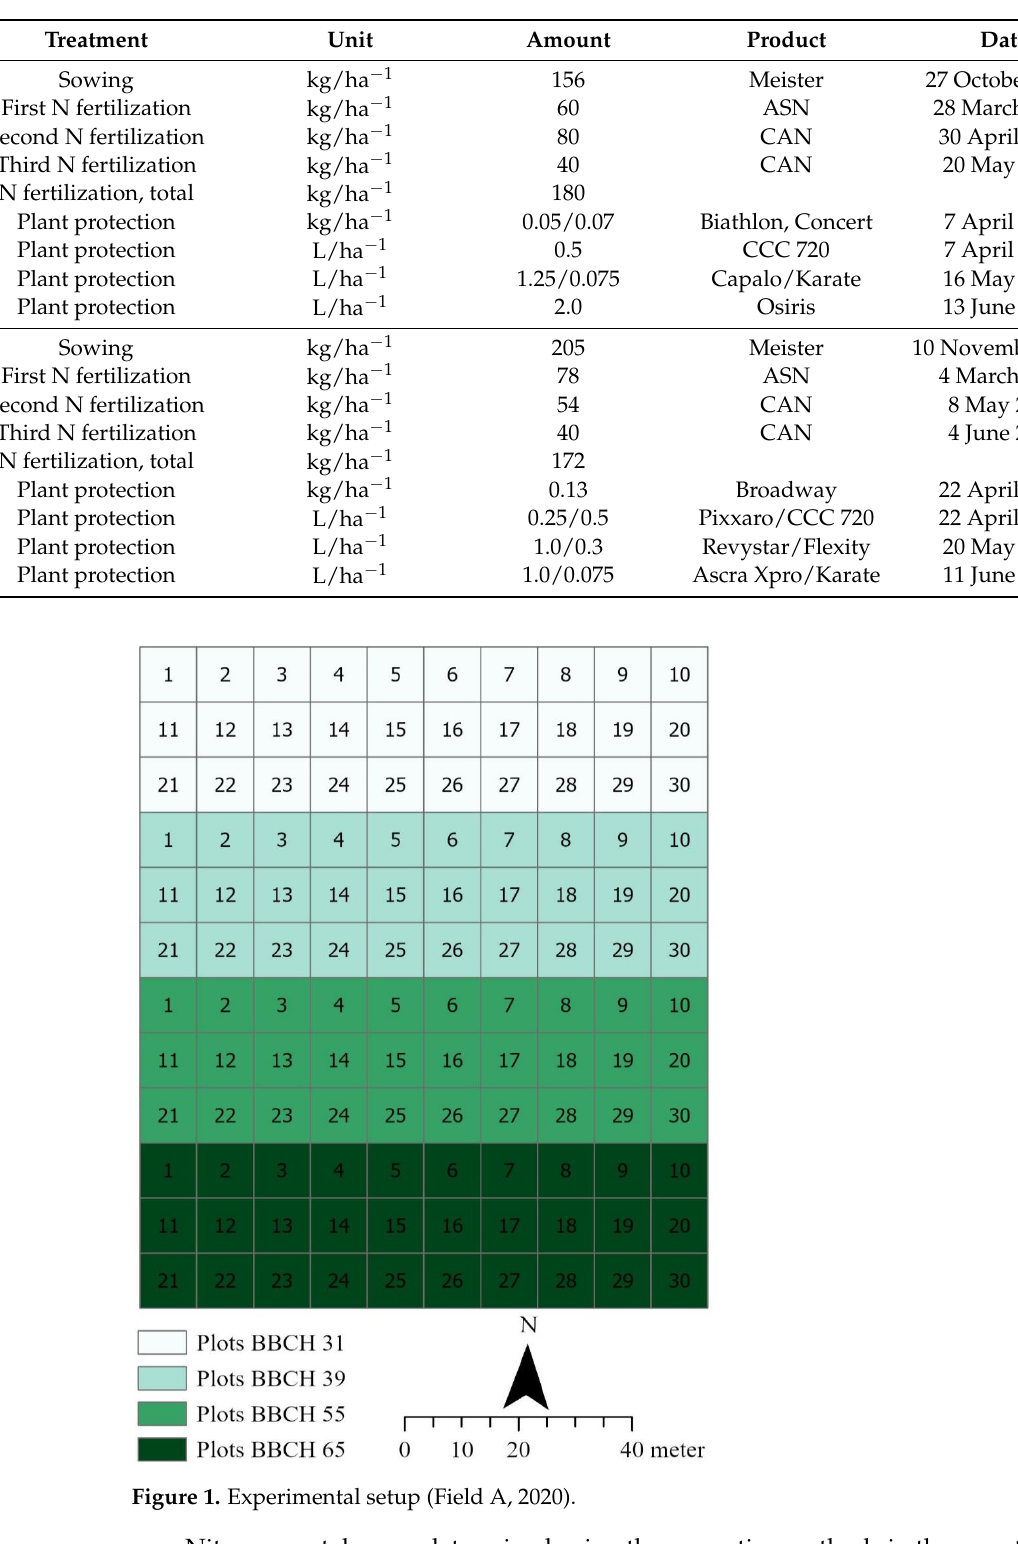
Table 3. Crop management of the trial fields.